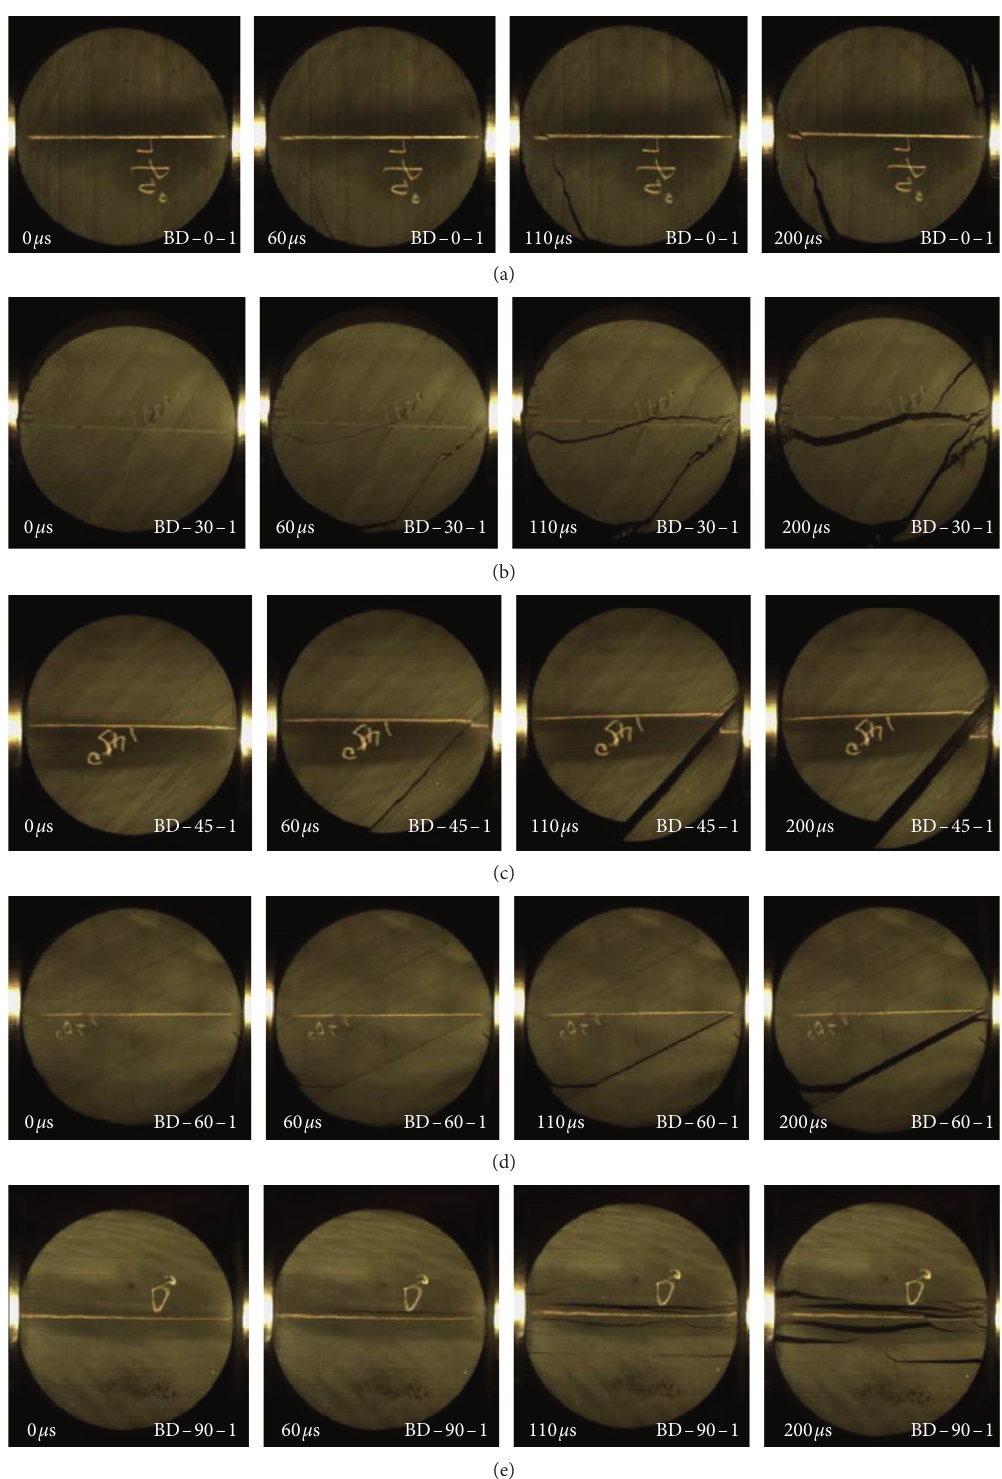
Figure 8: Typical failure modes of samples with different dip angles. (a) θ � 0 ° , (b) θ � 30 ° , (c) θ � 45 ° , (d) θ � 60 ° , and (e) θ � 90 °